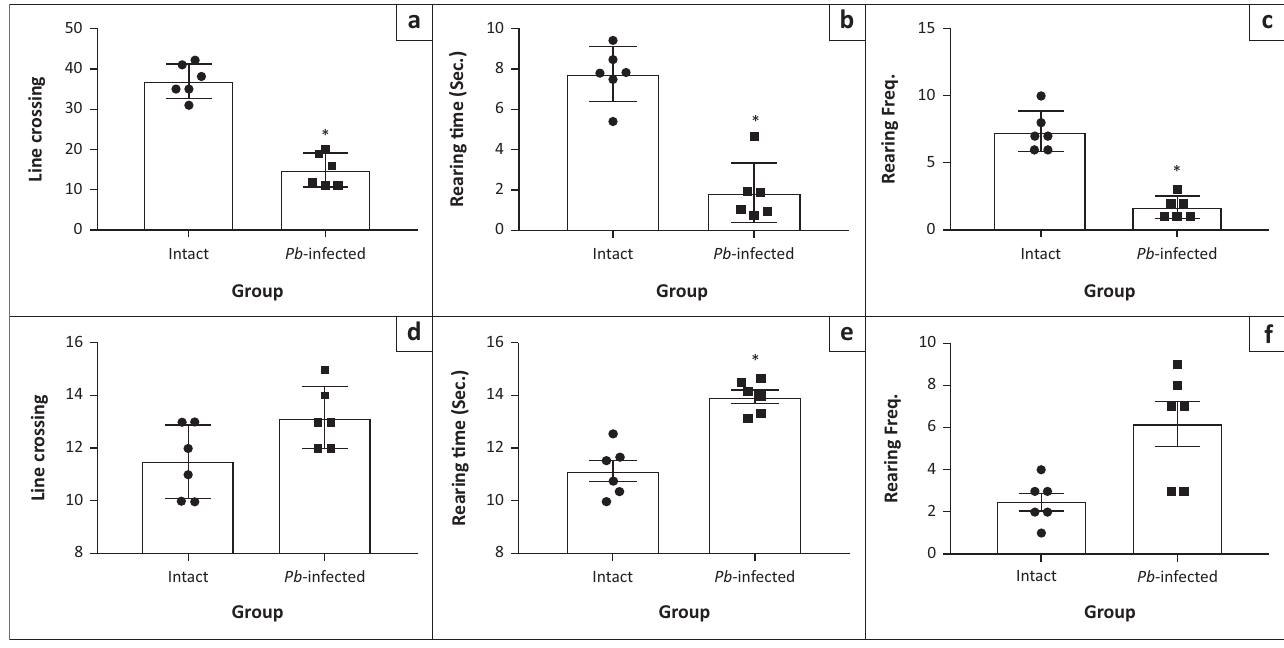
FIGURE 4: Motor behavioural indices in Pb - induced malaria. (a) Number of line crossing during early phase of formalin test. (b) and (c) Time spent and frequency of rearing during the neurogenic pain phase of formalin test, respectively. (d) Number of line crossing during late (20–50 min) phase of formalin test. (e) and (f) Time spent and frequency of rearing during the inflammatory pain (late) phase of formalin test,